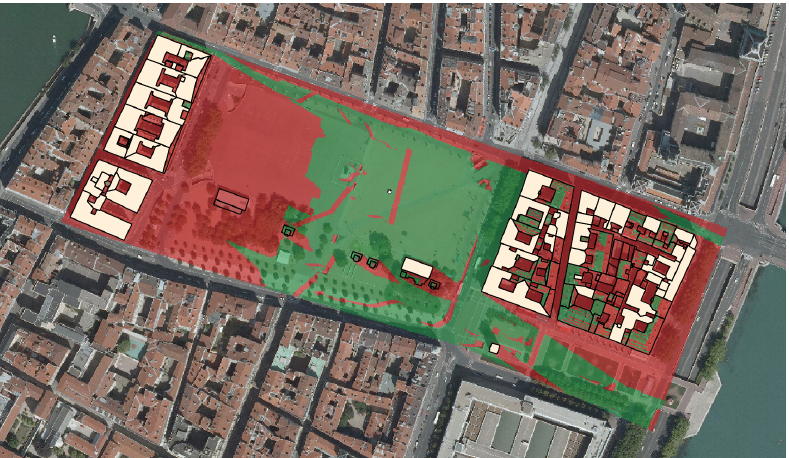
Figure 19. Buildings that have a facade from which the Fourvière Basilica can be seen are shown in white. Buildings from which the Basilica is only visible from the rooftop are